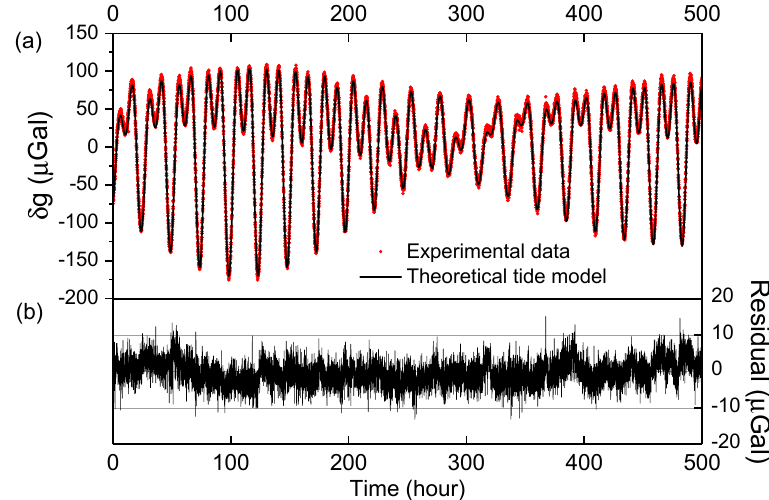
Figure 12. Continuous tidal signal measured for 500 h. Each dot is the result of 180 drops, three minutes average. ( a ) Red points represent experiment data; black solid line represents the theoretical tide model; ( b ) the residuals of the measured and theoretical data.